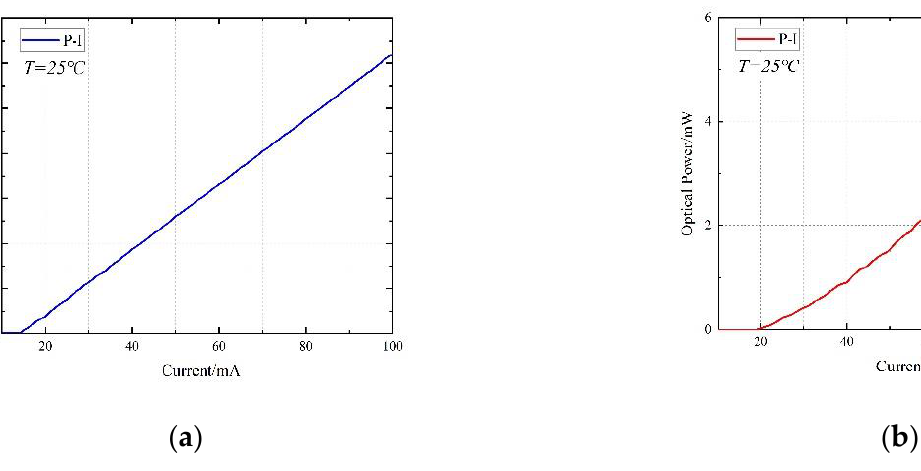
Figure 4. The temperature-current-wavelength tuning relationship of the two lasers: ( a ) wavelength tuning characteristics of the laser for CH 4 detection.; ( b ) wavelength tuning characteristics of the laser for HCl detection.